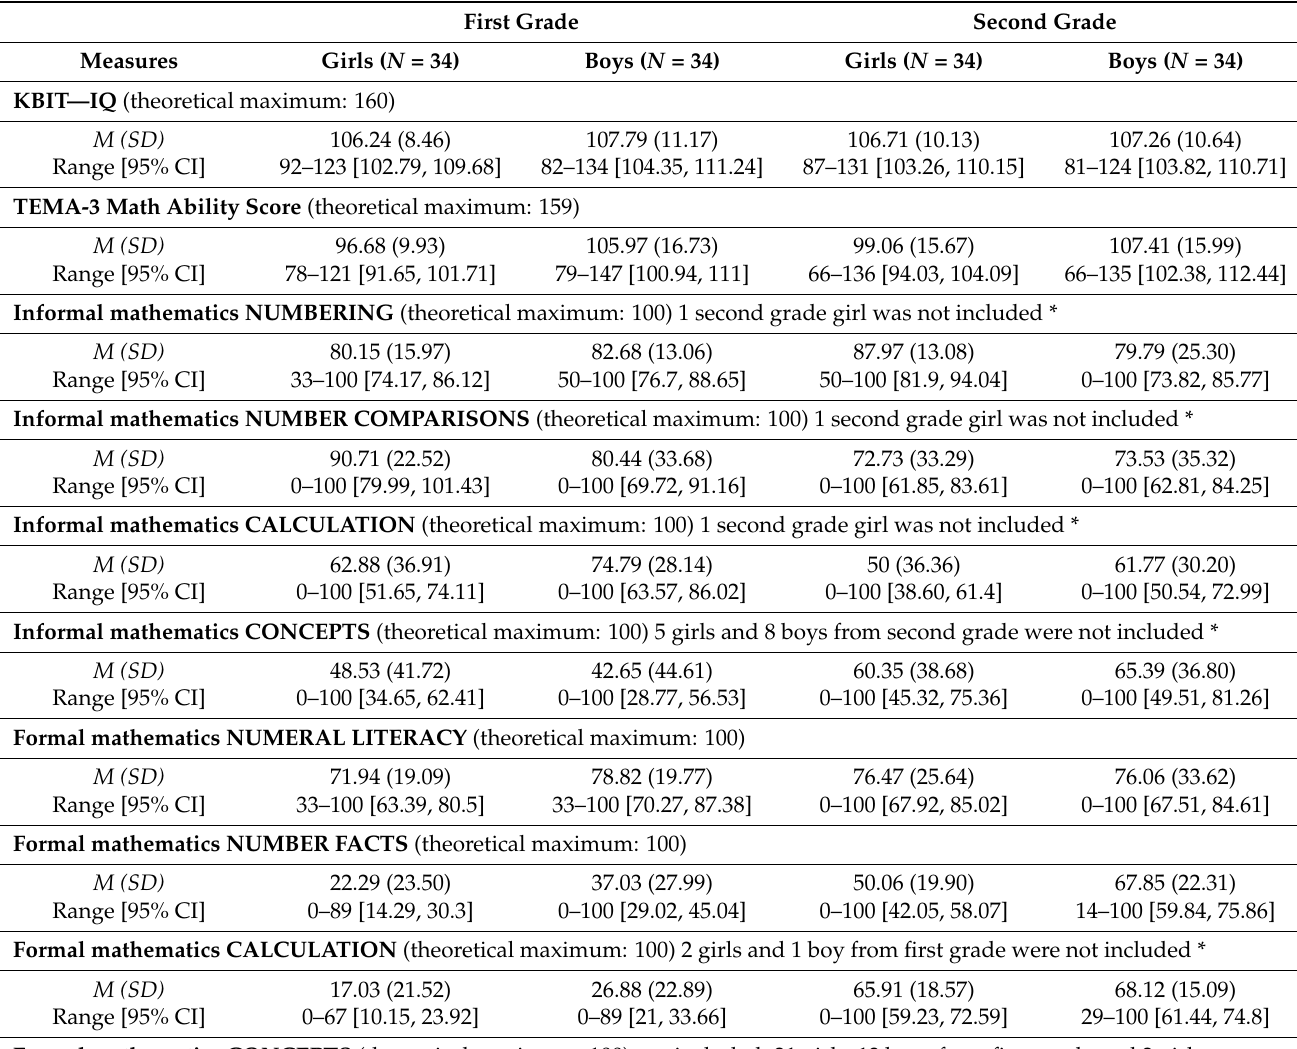
Table 2. Descriptive statistics of the dependent variables in univariate